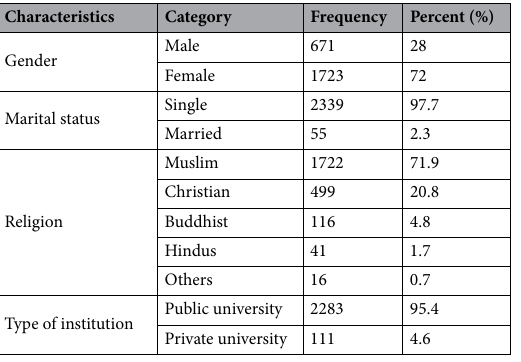
Table 2. Demographic characteristics of respondents (n =